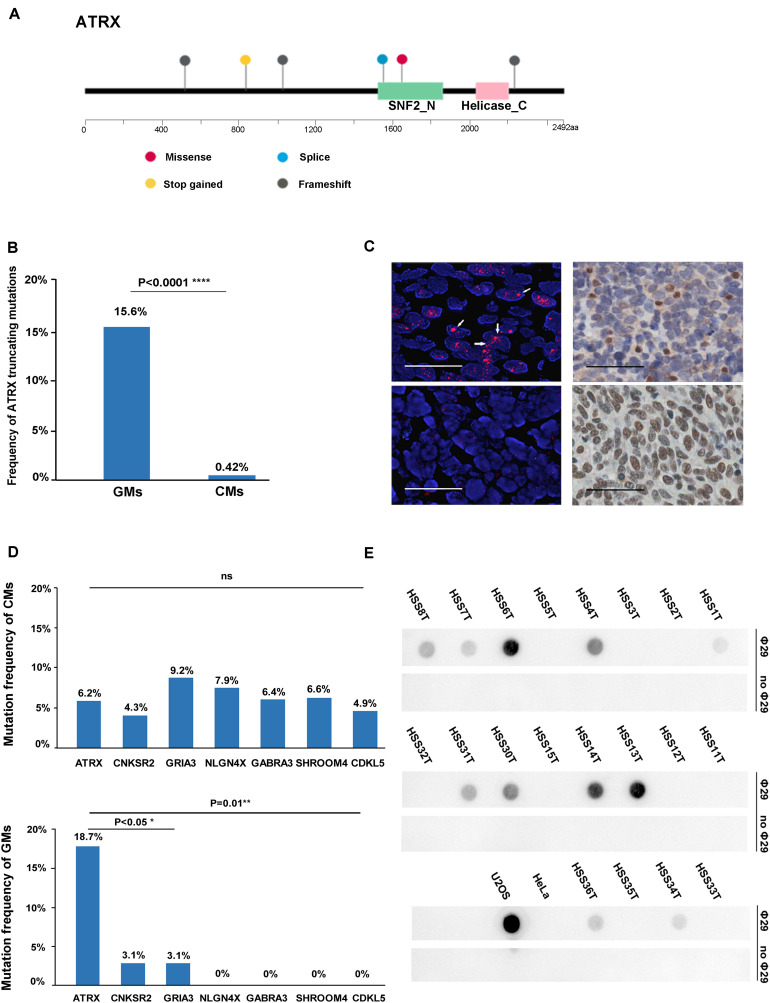
ATRX variations in the gene, protein, and function. (A) Diagram of the location of mutations across the coding region of ATRX in six GMs; (B) graphic representation of the frequency of truncating mutations in GMs (n = 32) and CMs (n = 468); (C) mutation frequency of similar-sized large genes on chromosome X: CNKSR2 (20/468,4.3%; chrX:21,393,016-21,659,655; and size: 266,640 bp), GRIA3 (43/468,9.2% chrX:122,318,388-122,616,895; and size: 298,508), NLGN4X (37/468,7.9%; chrX:5,808,083-6,146,706; and size: 338,624 bp), GABRA3 (30/468, 6.4%; chrX:151,335,634-151,619,831; and size: 284,198 bp), SHROOM4 (31/468, 6.6%; chrX:50,334,643-50,557,044; and 222,402 bp), and CDKL5 (20/468, 4.3%; chrX:18,443,725-18,671,749; and size: 228,025 bp) compared to ATRX in CMs and GMs, respectively; (D) Left: representative images of FISH performed with a PNA probe to detect telomeres. (Top) Example of an ALT-positive tumor with an ATRX mutation (HSS8T). Large, ultrabright telomere FISH signals (red) indicative of ALT are highlighted by the arrows. (Bottom) Example of an ALT-negative GM without an ATRX mutation (HSS2T; scale bars, 0.1 mm); right: representative images of immunohistochemistry performed to detect ATRX in the same tumors. (Top right) HSS8T harboring ATRX mutation, and in the (bottom right), HSS2T harboring wild-type ATRX (scale bars, 0.25 mm); (E) C-circle dot blot. Rows marked “Φ29” were treated with Φ29 polymerase to amplify C-circles. Prominent dots in these rows represent the presence of C-circles. Rows marked “without Φ29” as internal controls represent the group without amplification.